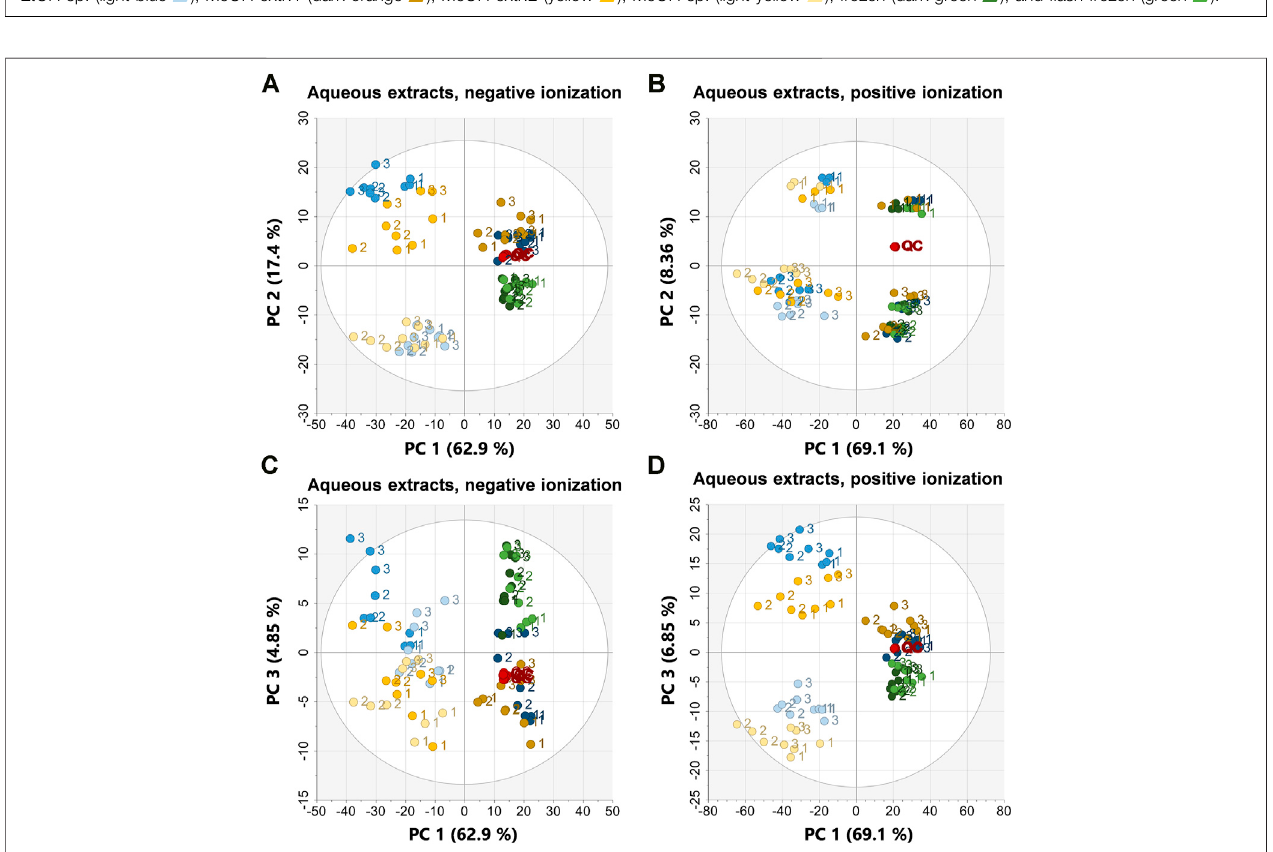
FIGURE 3| PCA scores plots ofthe aqueous extracts in negative ionization (R2X (cid:2) 0.974, Q2 (cid:2) 0.949) to the left and positiveionization (R2X (cid:2) 0.966, Q2 (cid:2) 0.938) on the right. (A) PC1 vs. PC2 in negative ionization, (B) PC1 vs. PC2 in positive ionization, (C) PC1 vs. PC3 in negative ionization, (D) PC1 vs. PC3 in positive ionization. Labelsdenotethespecimenid:s1,2,and3.EtOHextr.1(darkblue ),EtOHextr.2(blue ),EtOHsp.(lightblue ),MeOHextr.1(darkorange ),MeOHextr.2(yellow ), MeOH sp. (light yellow ), frozen (dark green ) and fl ash frozen (green ), and QC-samples (red ).